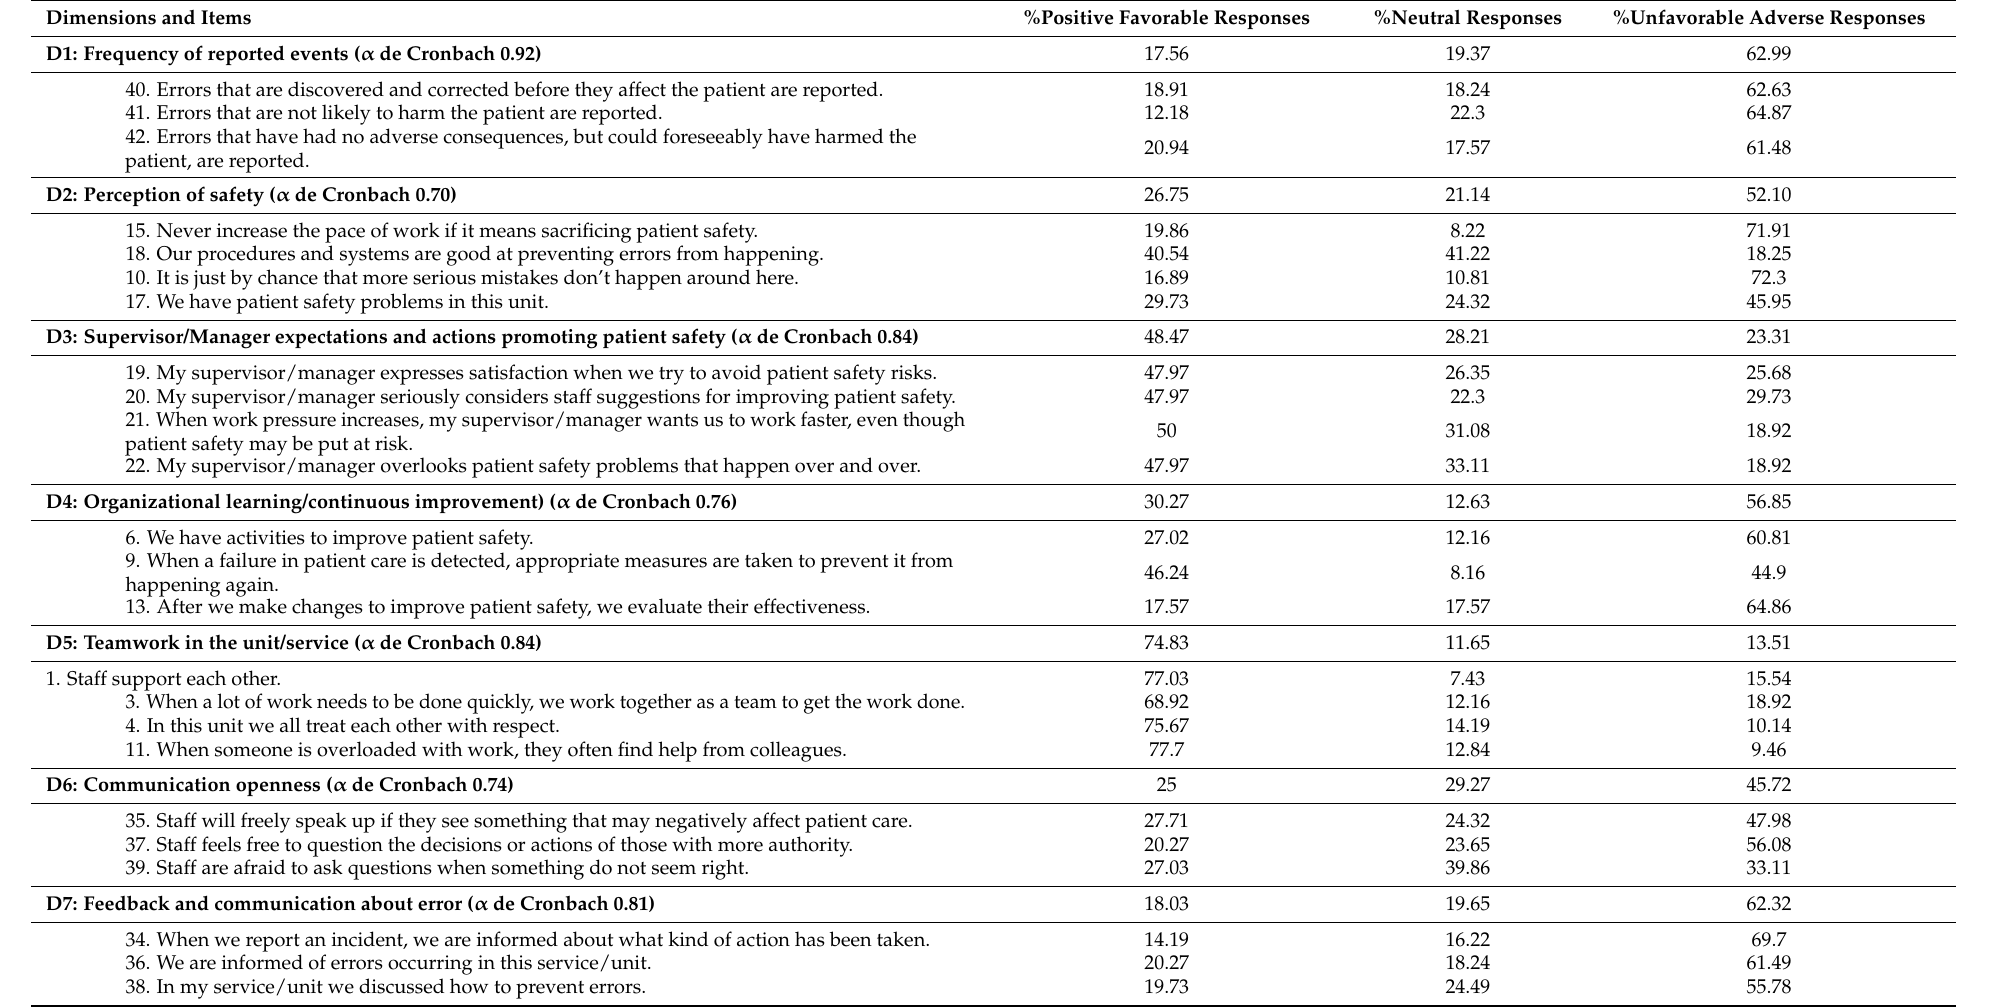
Table 2. Analysis of dimensions and